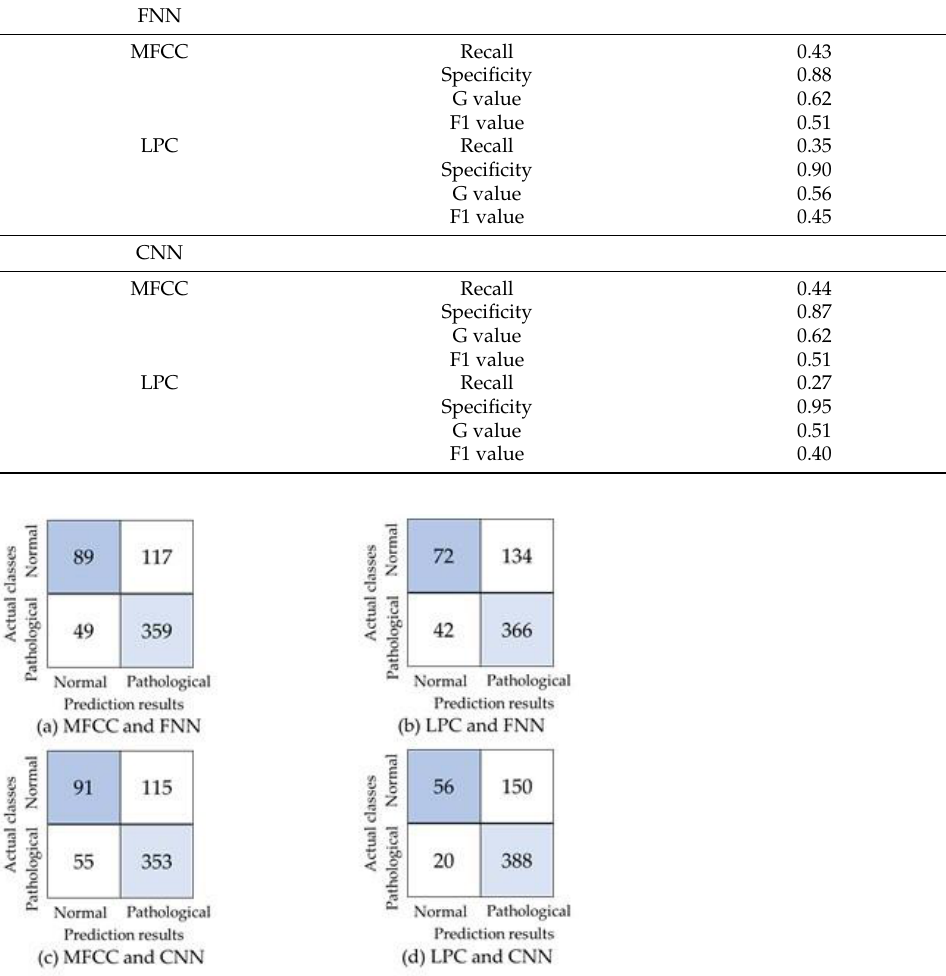
Table 4. Evaluation measures obtained by each model on the class-imbalanced SVD.